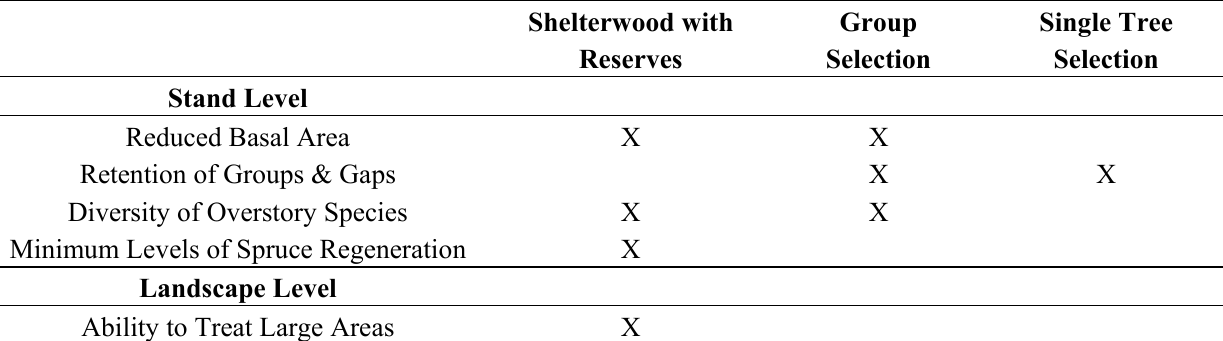
Table 5. Trade-offs between the different treatments assessed at the stand and landscape level. Shelterwood